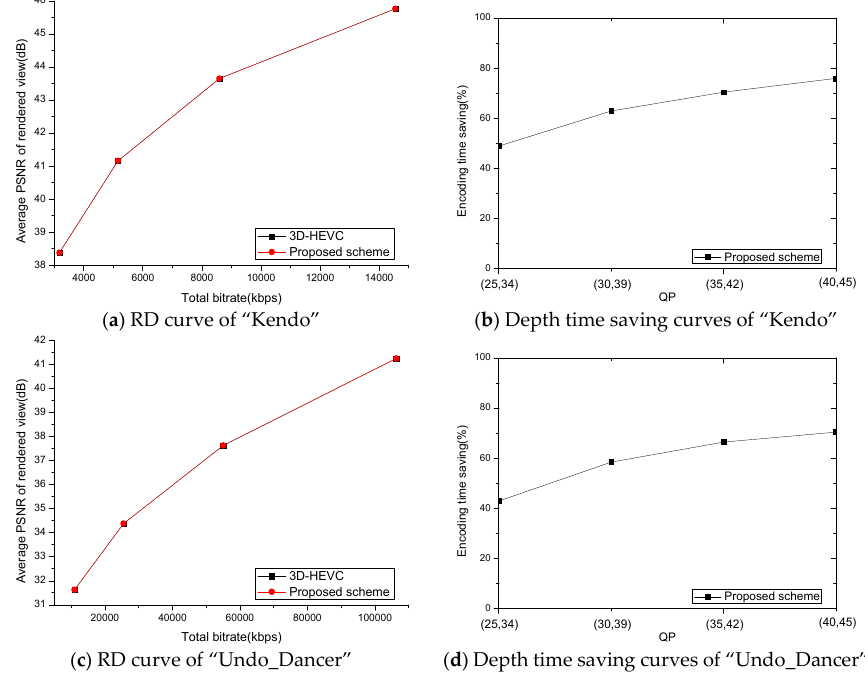
Figure 5. RD performance and depth map time saving under different QPs (25, 34), (30, 39), (35, 42), and (40, 45) for the “All-Intra” condition.